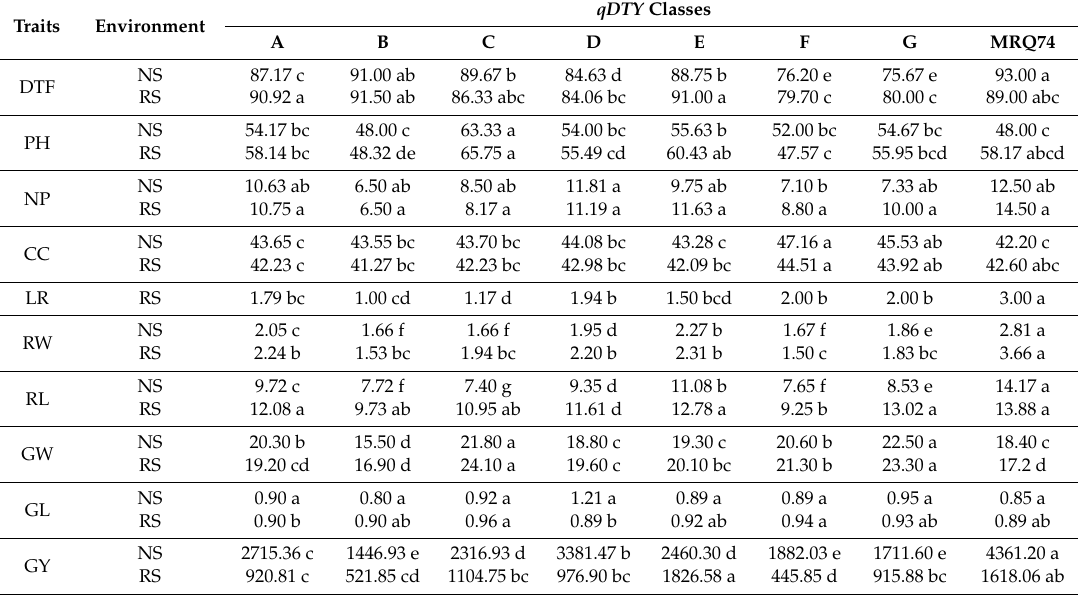
Table 1. Mean values of traits of MRQ74 drought yield quantitative trait loci (qDTY) classes under NS and